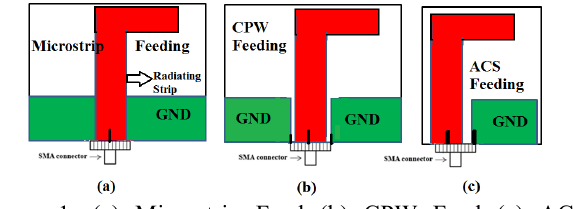
plane of CPW-fed structure. A summary table of literature